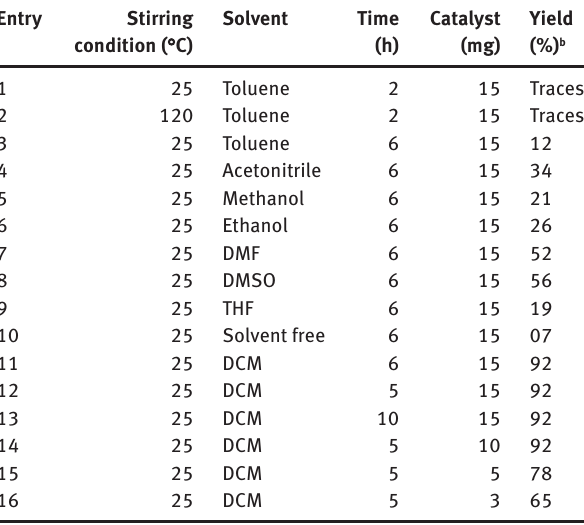
Table 1: Optimization of reaction conditions for the synthesis